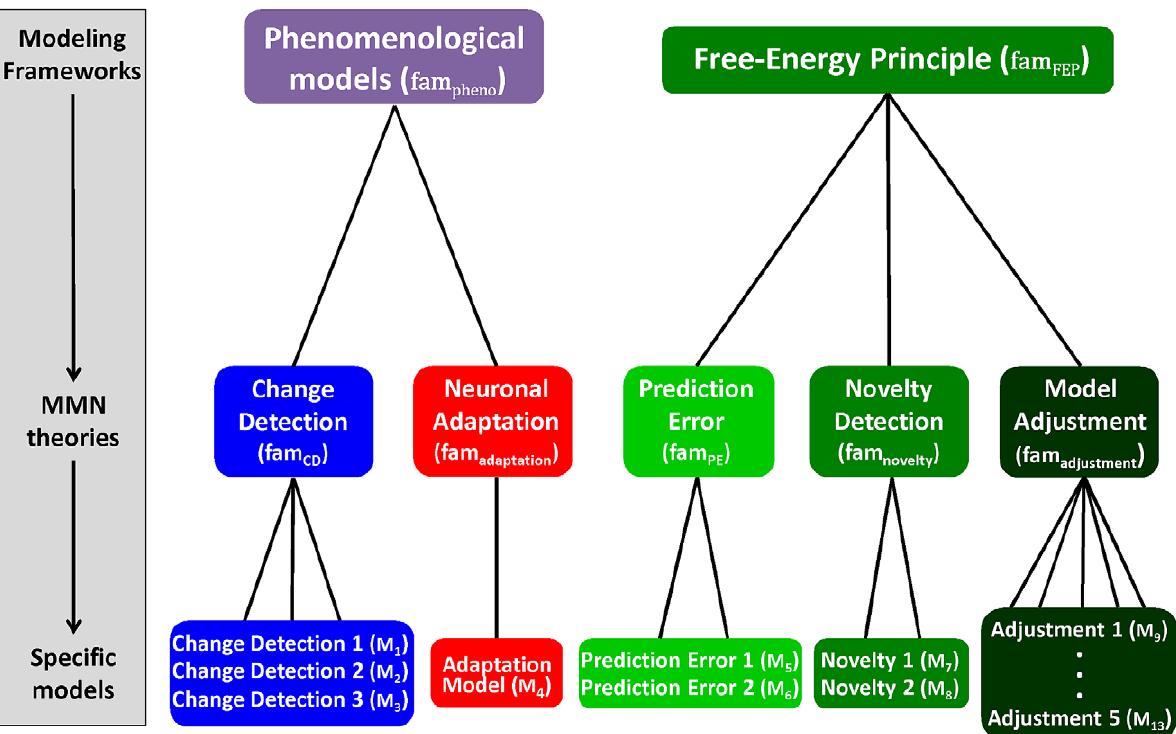
Figure 2. Hierarchical structure of the model space: models, theories, and frameworks. The MMN models developed in this article can be organized into a tree structure. The leaves at the bottom of the tree represent individual models of trial-wise MMN amplitudes, and the nodes above represent sets of models (model families). The nodes at the third level represent modelling frameworks. Three theories (the prediction error hypothesis, the novelty detection hypothesis, and model adjustment hypothesis) were formalized under the framework of the free-energy principle ( fam FEP ). This framework explicitly models information processing, which makes it fundamentally different from phenomenological explanations ( fam pheno ), such as change detection and adaptation models.